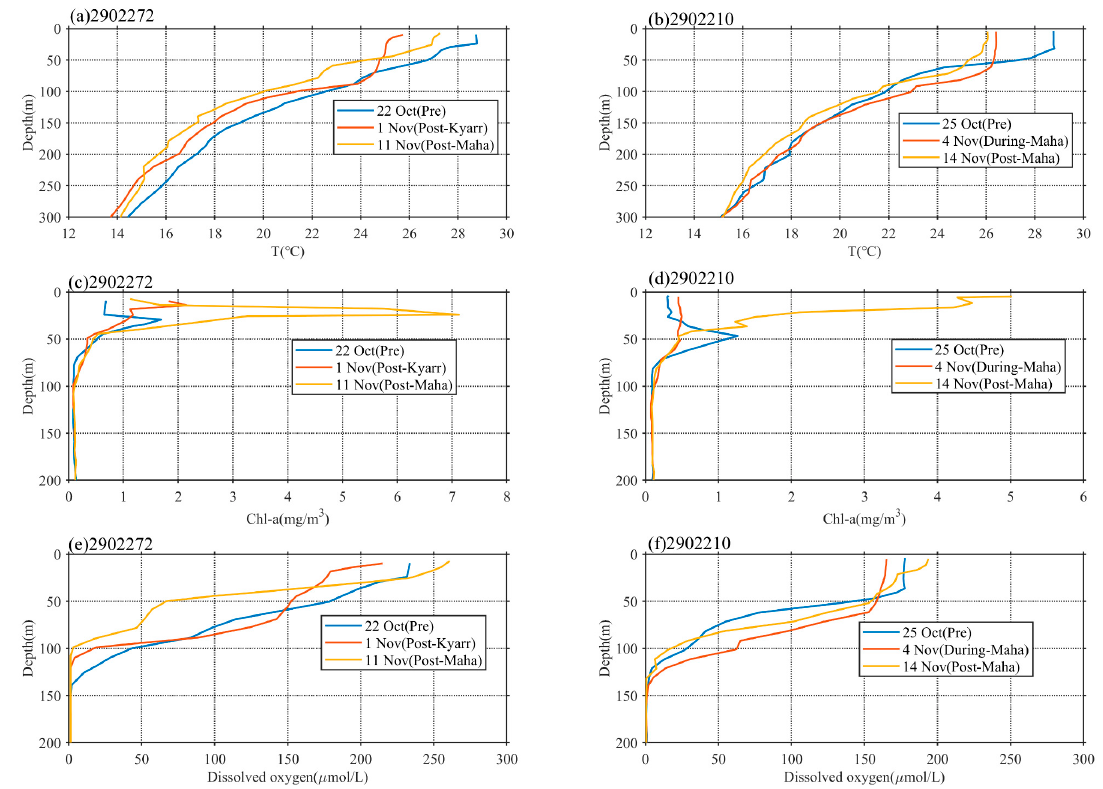
Figure 6. In situ vertical profiles of temperature ( a , b ), chl-a concentration ( c , d ), and dissolved oxygen concentrations ( e , f ) at Bio-Argo floats 2902272 and 2902210.